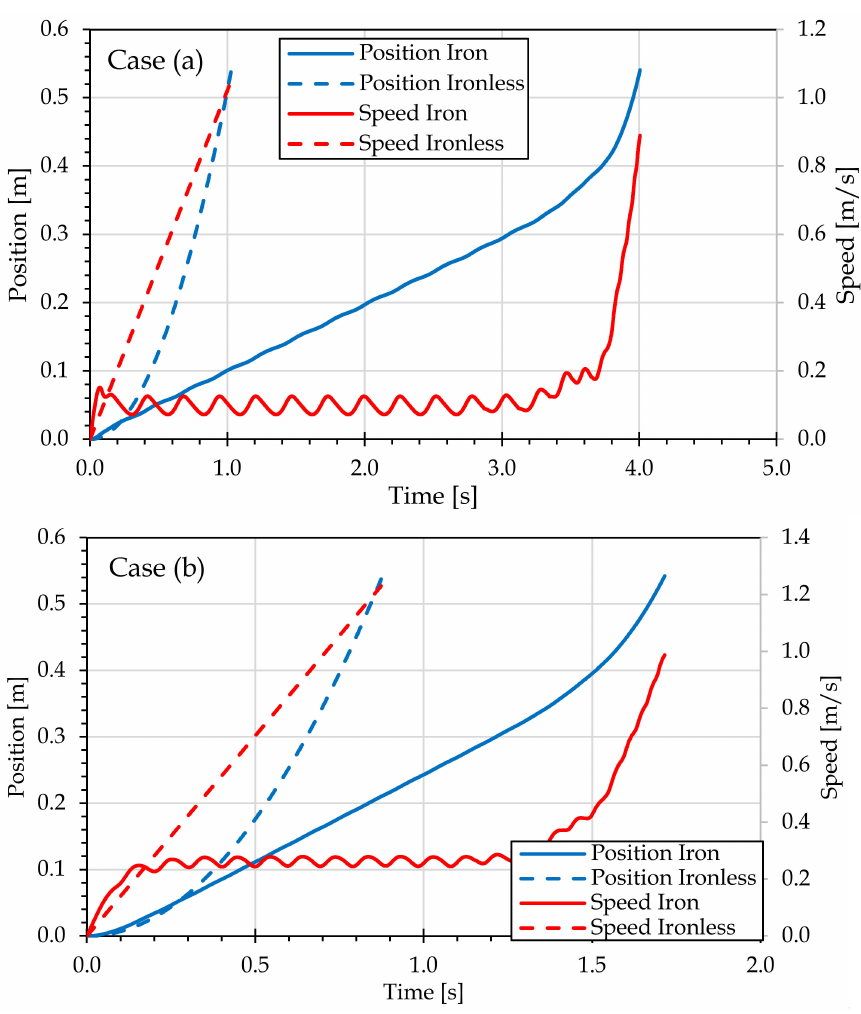
Figure 21. Speed and position trend comparison: case ( a ) 7 kg and 0 Ohm; case ( b ) 7 kg and 20